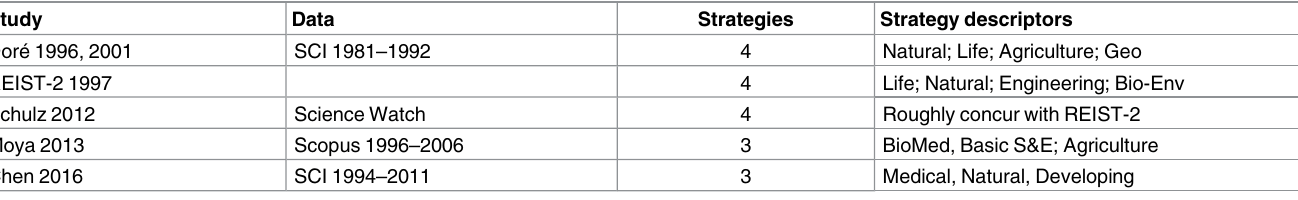
Table 1. Researchstrategies as identified by studies of national publication patterns.